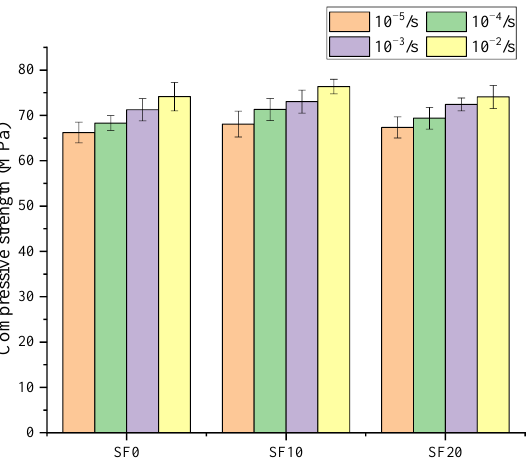
Figure 5. Compressive strength of concrete specimens with 5 MPa confining pressure without F–T cycles.